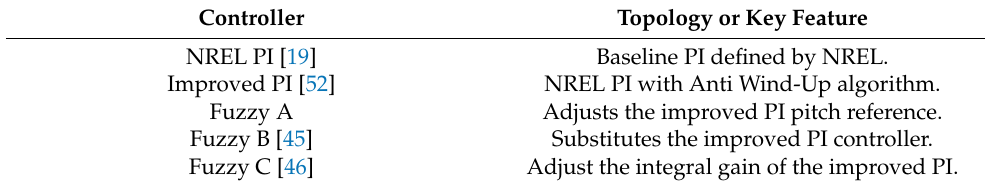
Table 10. Controllers evaluated. Fuzzy A is proposed in this paper.